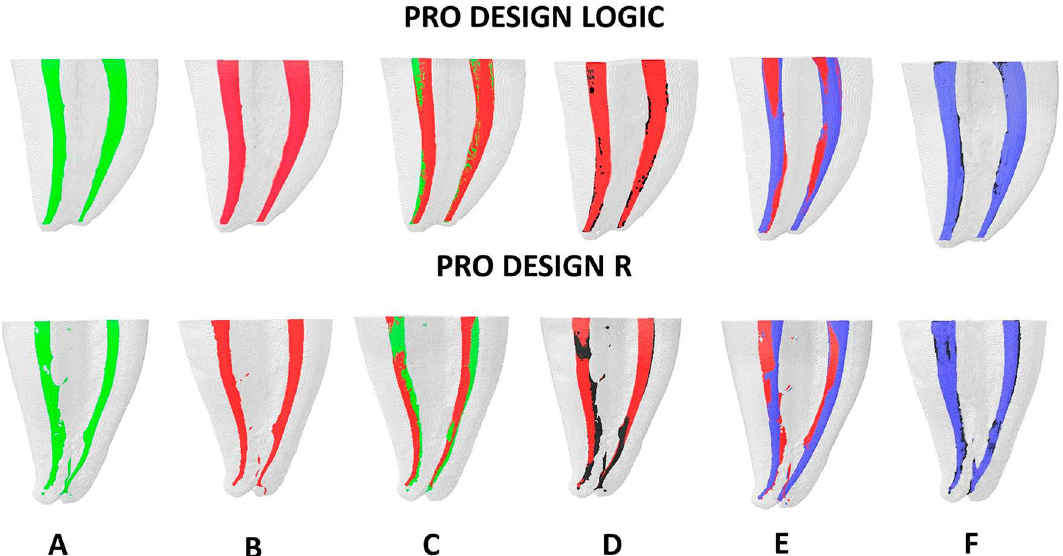
Figure 2- Micro-CT rendering of mandibular molar mesial canals prepared by using PDL and PDR, showing: A, preoperative canal (green); B, post-instrumentation (red); C, superimposition of preparation on initial canal; D, debris (black); E, superimposition of the apical enlargement (purple) on preparation; and F, apical enlargement with